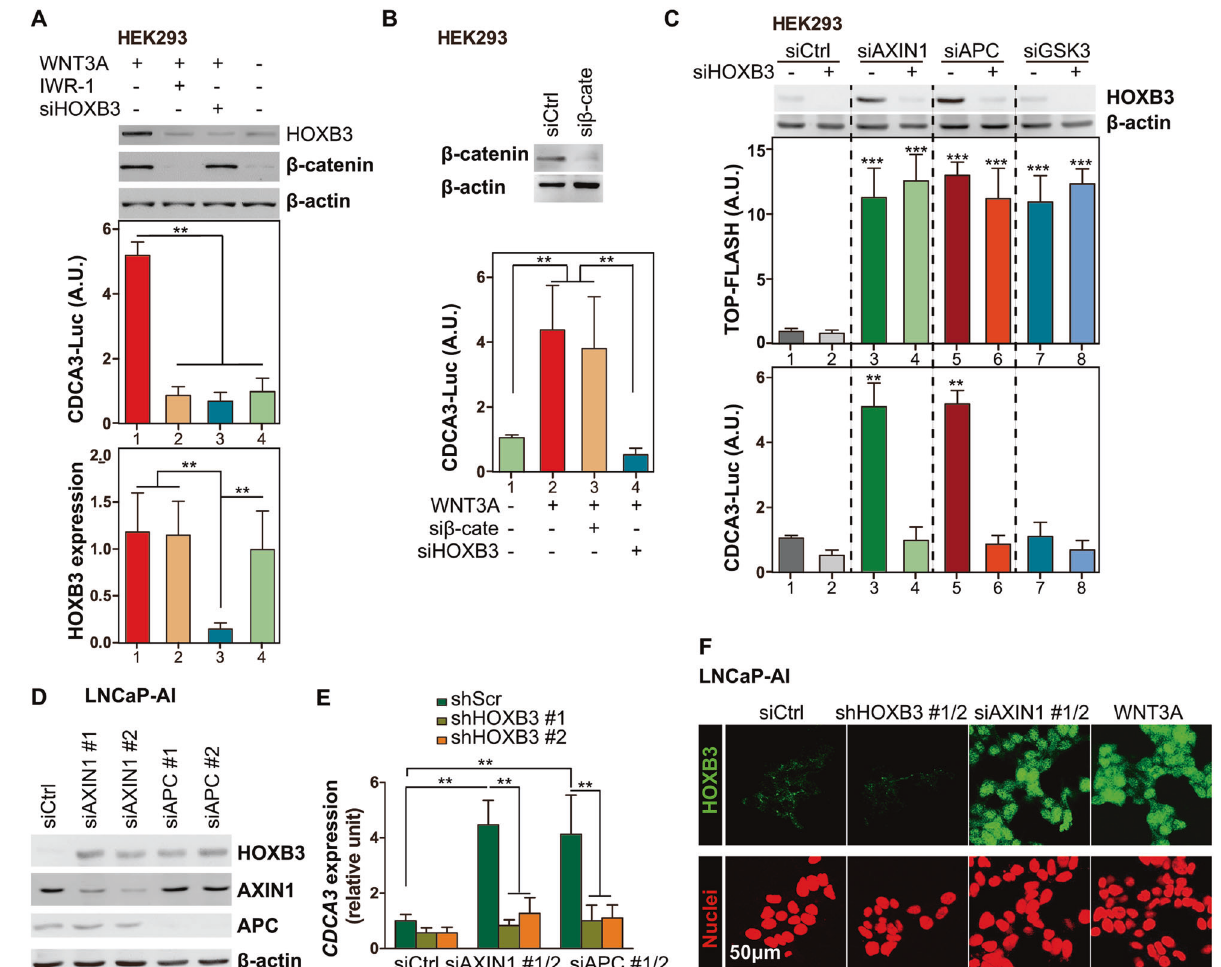
WNT3A and IWR-1 (enhancing AXIN1 stabilization). The results of western blots (for HOXB3, β -catenin and β -actin), luciferase assay (for CDCA3- Luc recording HOXB3-dependent transcriptional activity), and qRT-PCR assay (for HOXB3) were presented. Data were normalized to control (lane 4). B HEK293 cells were transfected with CDCA3-Luc and siRNAs (siCtrl, siHOXB3, or si β -catenin). Transfected cells were cultured in medium with or without WNT3A. The results of western blots ( β -catenin and β -actin) and luciferase assay (CDCA3-Luc) of the indicated samples were presented. In luciferase assay, data were normalized to control (lane 1). C Top: Western blot of HOXB3 in HEK293 cells as indicated, transfected with siRNAs targeting control (siCtrl), AXIN1 (siAXIN1), APC (siAPC), or GSK3 (siGSK3), followed by another siRNAs targeting control or HOXB3. Bottom: luciferase assays of TOP-FLASH ( β -catenin/TCF-dependent transcriptional activity) or CDCA3-Luc reporters in the same cells used for western-blot. D Western blots of HOXB3, AXIN1, APC and β -actin in LNCaP-AI cells transfected with siRNAs targeting control (siCtrl), AXIN1 (siAXIN1) or APC (siAPC). E qRT-PCR assay of CDCA3 in LNCaP-AI cells after stable transfected by shScr or shHOXB3. F Immuno fl uorescent staining of HOXB3 (green) in LNCaP-AI cells transfected with indicated siRNAs. Nuclei are stained with DAPI (red). Error bars indicate mean ± SD. ** p < 0.01, *** p <